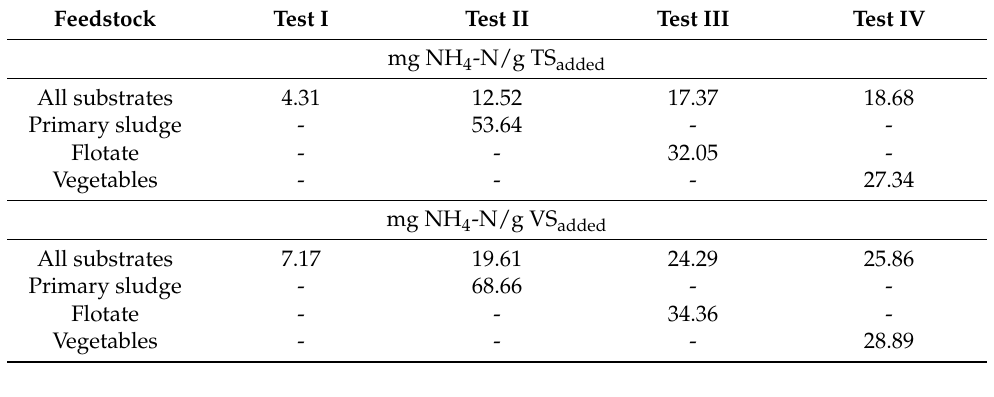
Table 5. Unit value of ammonia nitrogen release rate during methane fermentation (T = 36 ◦ C, HRT = 29 days).